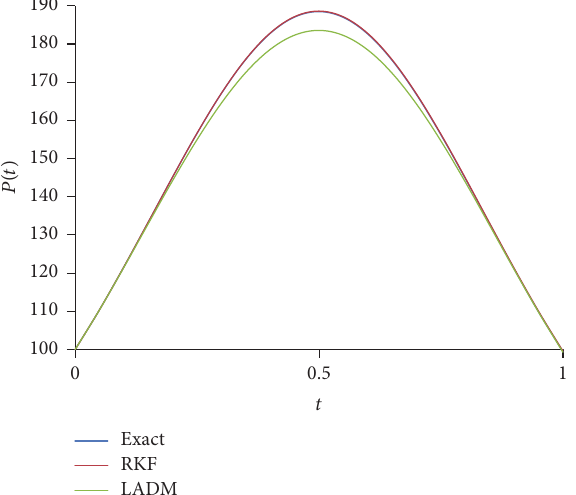
Figure 2: Evaluation among the exact solution and the solutions obtained by using LADM and RKF method for model II.